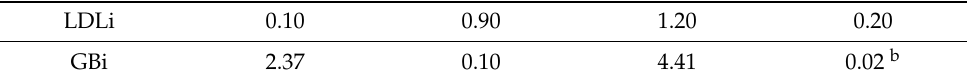
a —differences between the two experimental groups. b —differences between the 1st experimental and control group. c —differences between the 2nd experimental and control group. Legend : BH—body height, BWi—initial